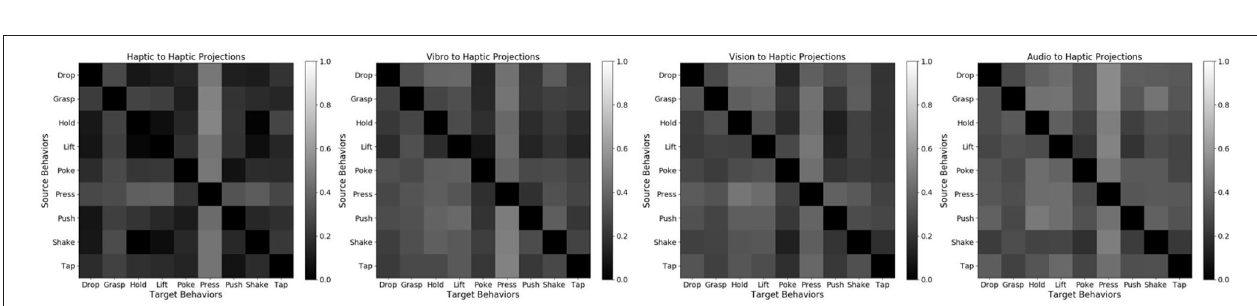
FIGURE 17 | Two sources β -VAE cross-behavior projections trained with zeros for target robot where the Accuracy Delta is minimum and corresponding β -VAE projections trained with target robot’s features.